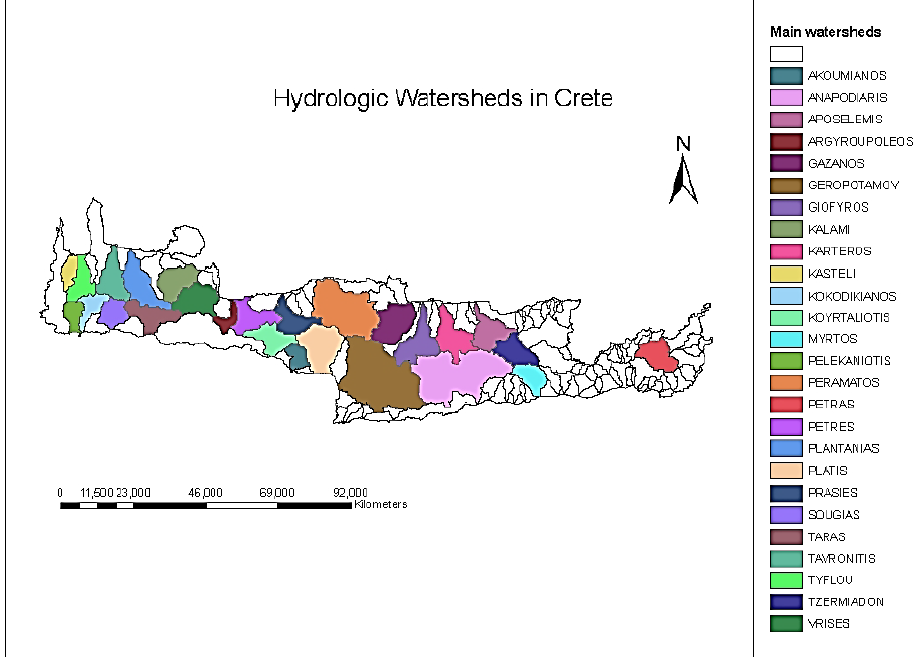
Figure 3. The most important hydrologic basins of Crete (modified from [43]).